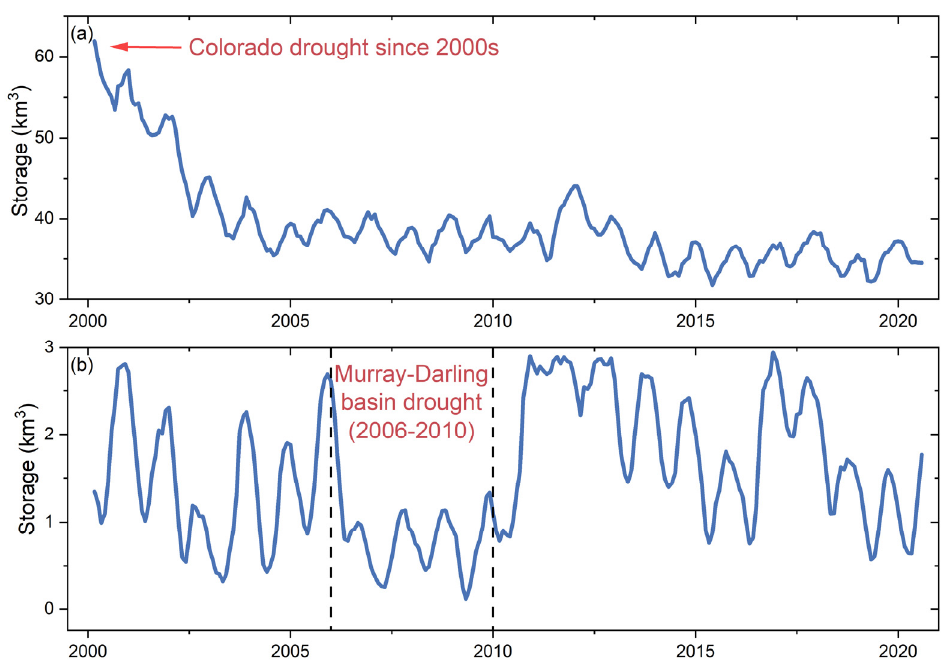
Figure 13. Total reservoir storage variations in the ( a ) Colorado and ( b ) Murray-Darling river basins.